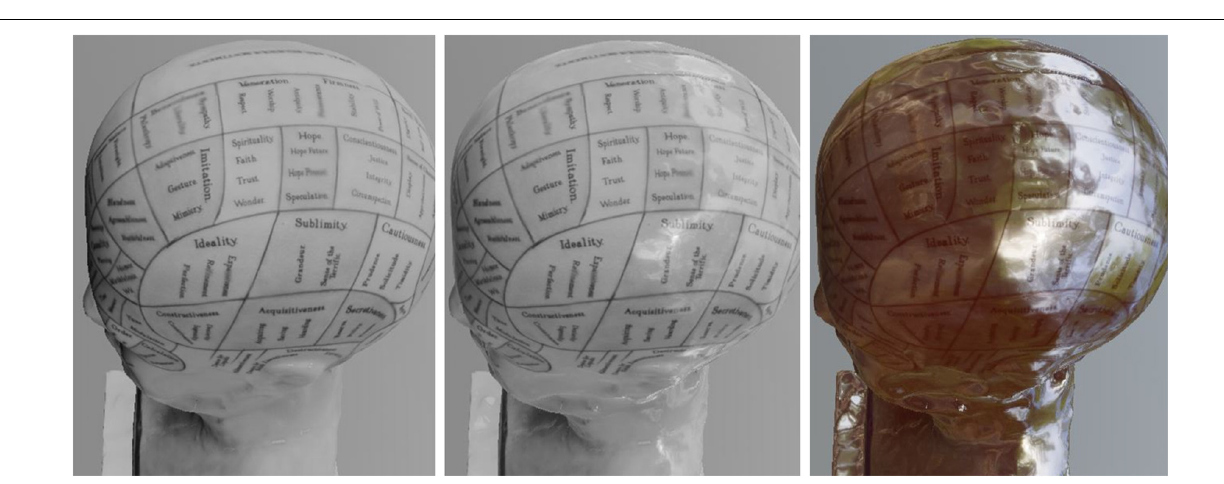
FIGURE 4 | Rendering changes to recreate the original appearance: without changes (left) , additional reflections to mimic the appearance of ceramics (middle) , and a fictional metallic appearance (right) ; screenshot taken in Blender (Blender Foundation,